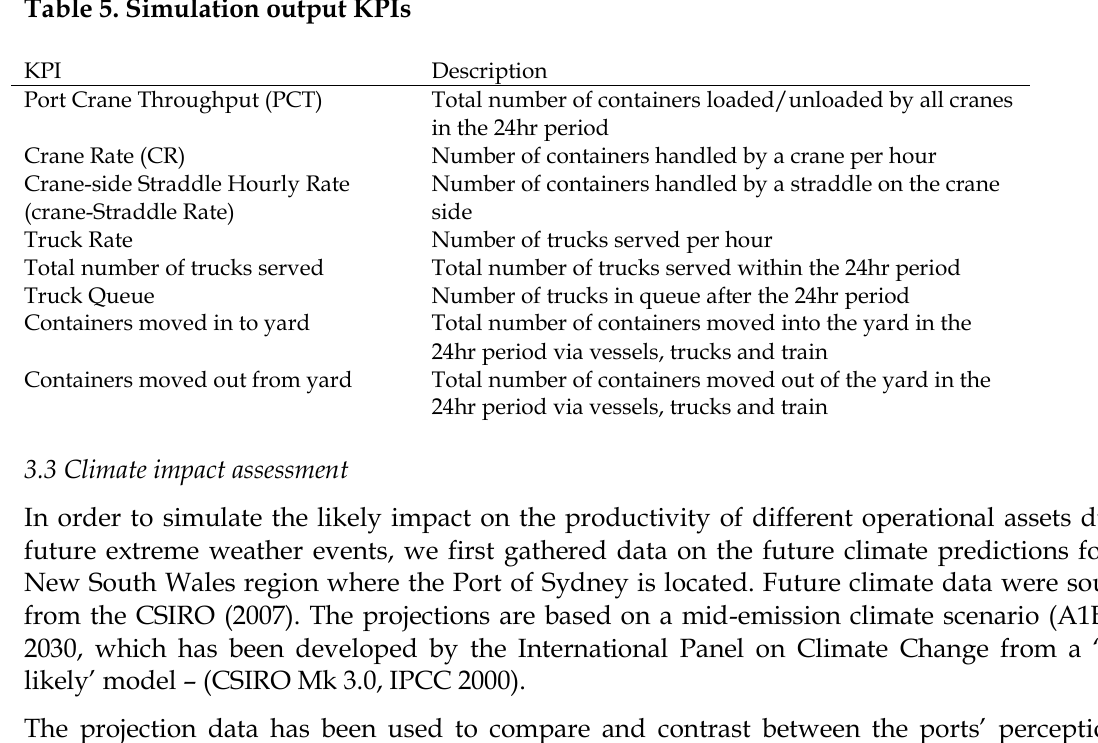
Table 5. Simulation output